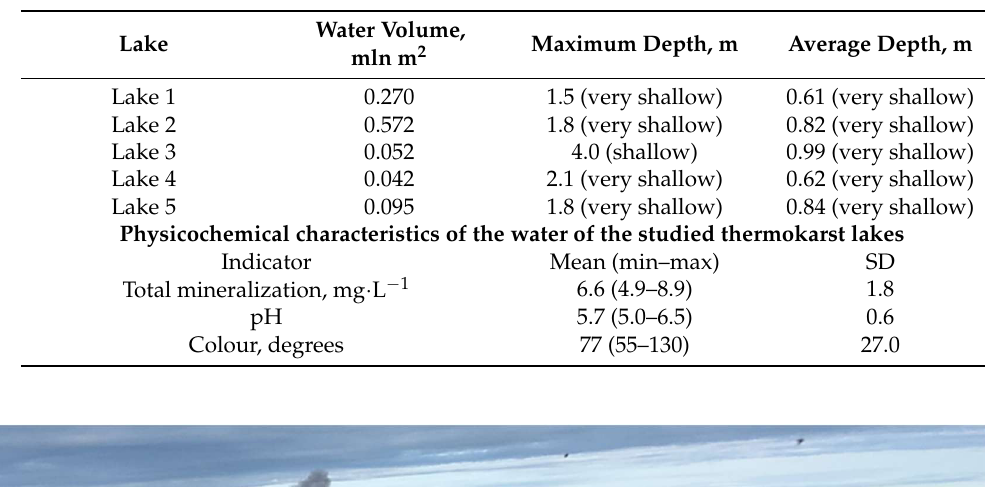
Table 2. Concentrations of heavy metals in snow melt and thermokarst lake waters of the Tazovsky District of the YNAO compared with permissible levels. Table 1. Morphometric features and physicochemical characteristics of the water of small thermokarst lakes of the Tazovsky Peninsula (expedition data, 2018; online Supplementary Material File S1).